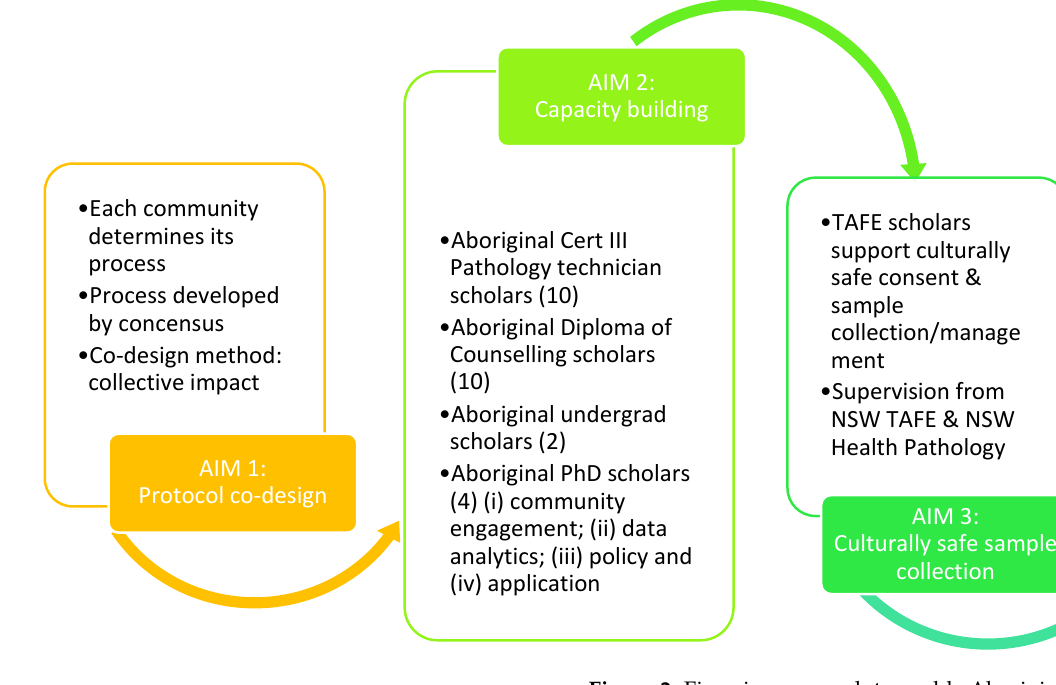
Figure 2. Five aim approach to enable Aboriginal Precision Medicine.